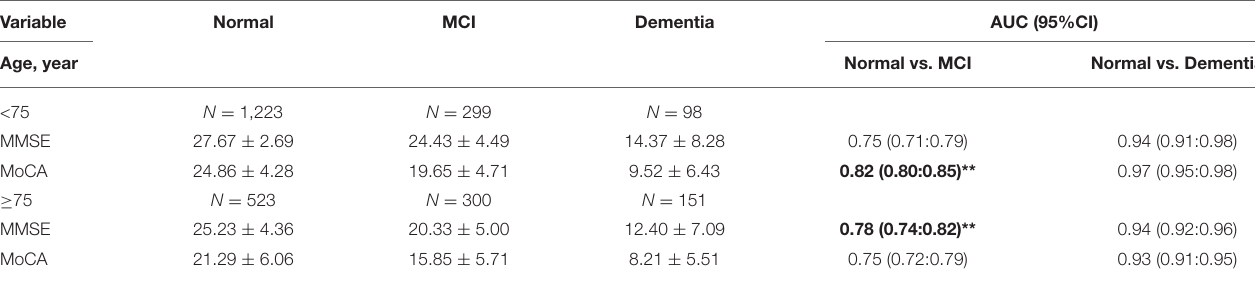
TABLE 3 | MMSE and MoCA data of the normal, MCI and dementia groups by age band. Variable Normal MCI Dementia AUC (95%CI)